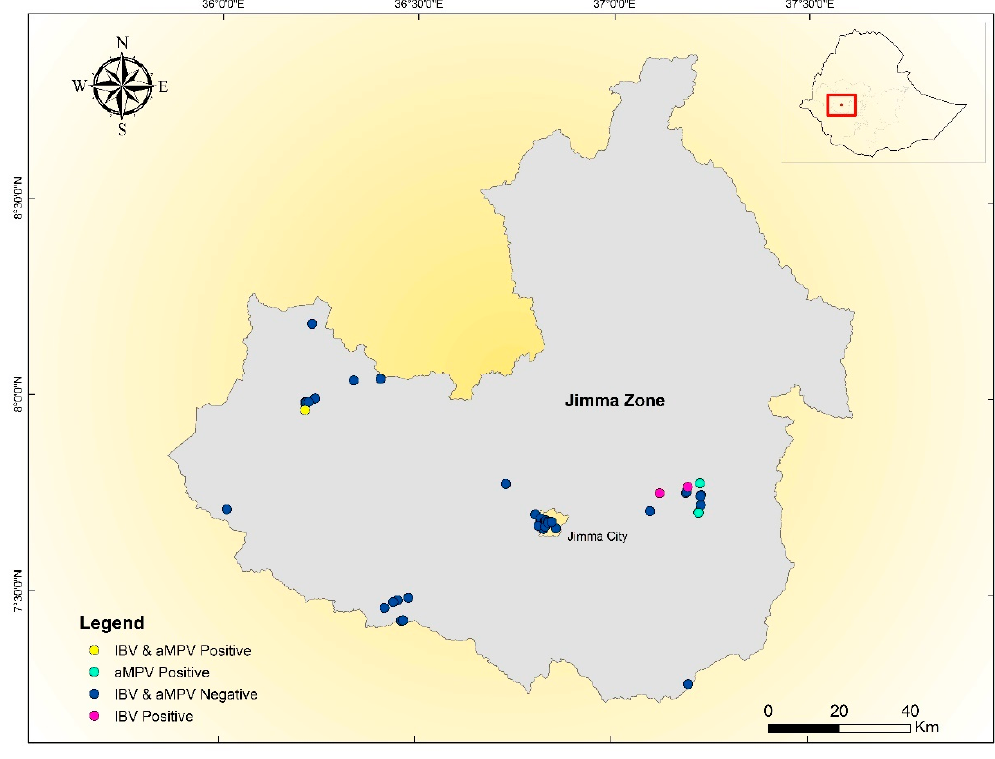
Figure 1. Farm locations of infectious bronchitis virus (IBV)-positive (pink), avian metapneumovirus (aMPV)-positive (green), co-infected (yellow), and negative (blue) cases.